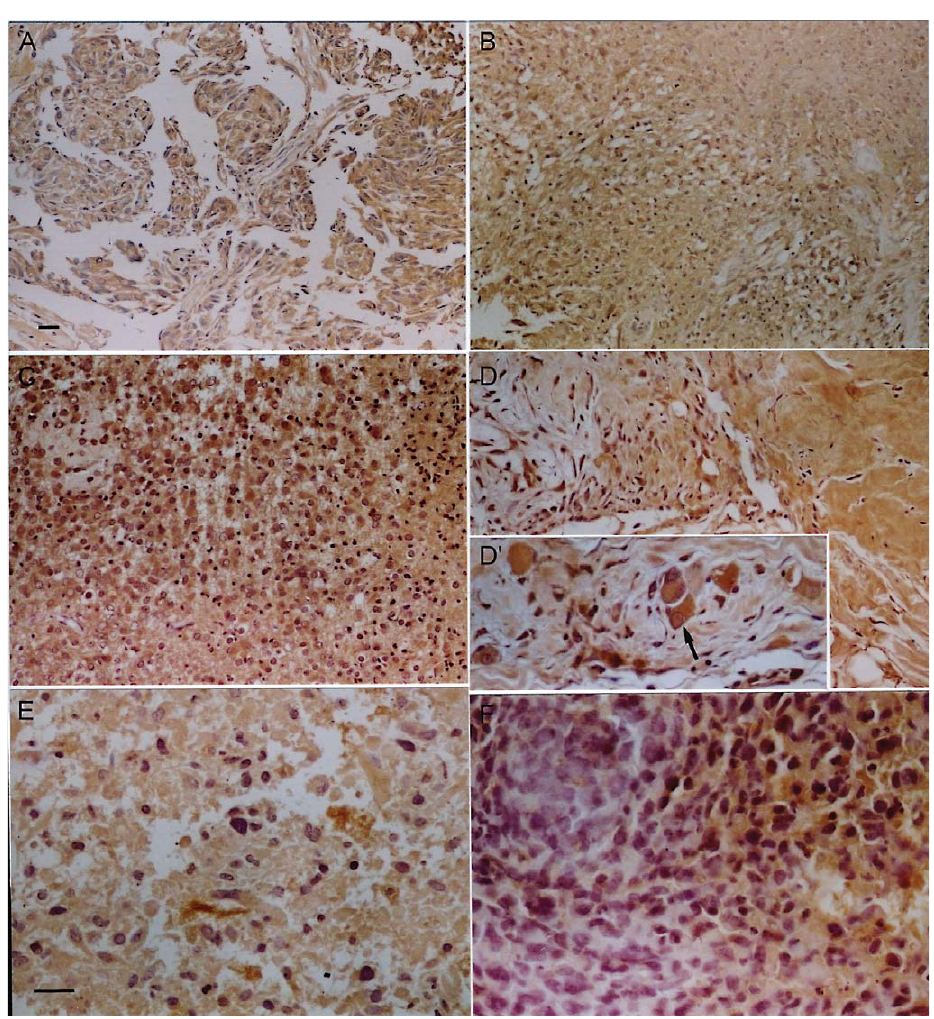
Fig. 4. Specific antibodies for WOX1 phosphorylation at Tyr33 (p-WOX) also indicated a similar immoreactive pattern to WOX1. Moderate to high immunopositive staining was observed in malignant meningioma (a), schwannoma (b), anaplastic astrocytoma (c, d), and grade VI glioblastoma (e, f). Under higher magnification, p-WOX expression could be observed in the nuclei of large tumor cells (arrow in d’) and proliferative small cells (f). Bar in a also for b, c and d. Bar in e is also for d’ and f. Bar=50 (cid:1)